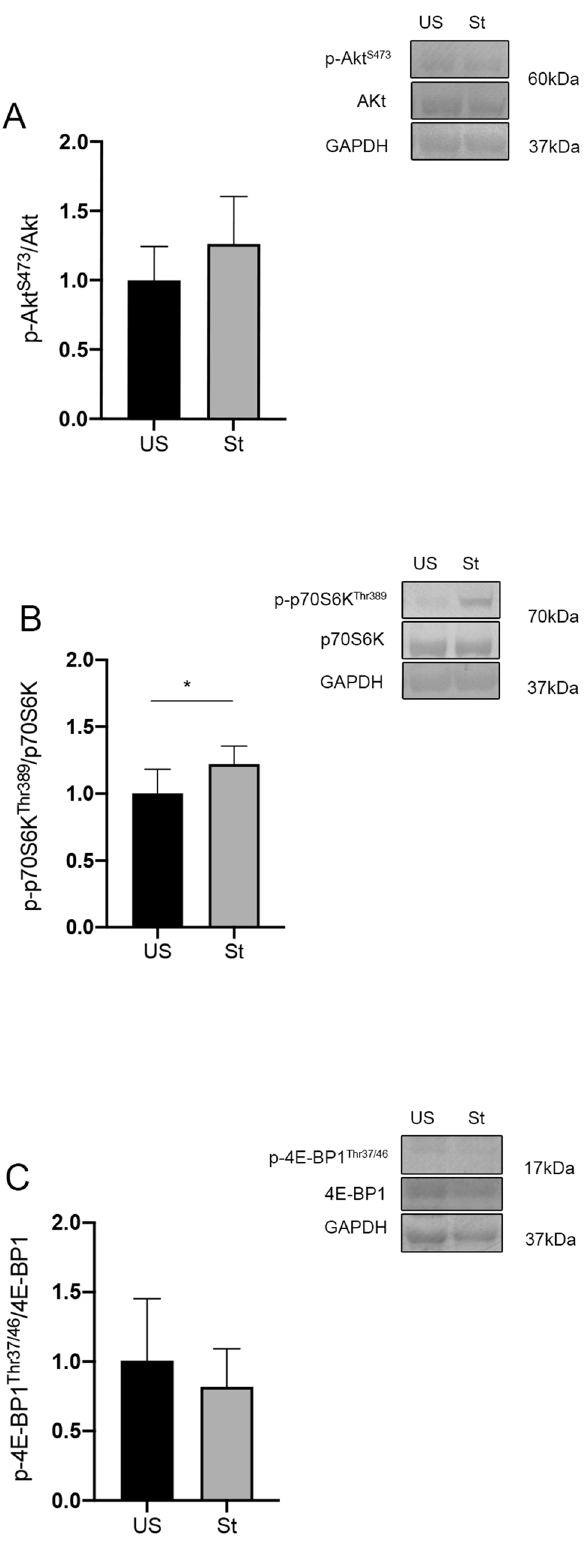
Figure 6. The phosphorylation levels of Akt, p70S6K, and 4E-BP1 measured with Western blotting. Representative western blot images and quantification of phosphorylation levels of ( A ) Akt, ( B ) p70S6K, and ( C ) 4E-BP1. US unstretched, St stretched. Values are expressed as mean ± SEM. *P < 0.05, n =